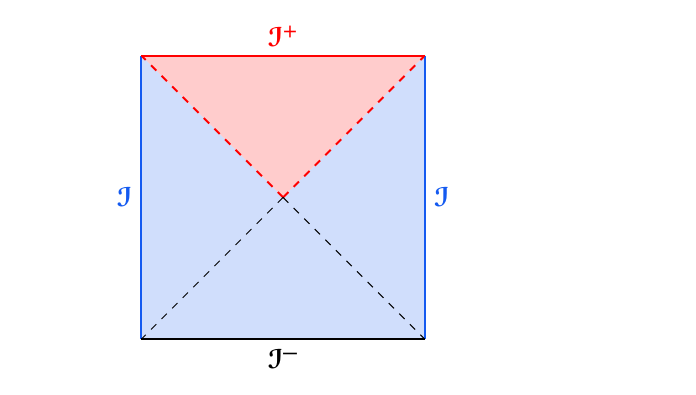
interior and AdS 2 2